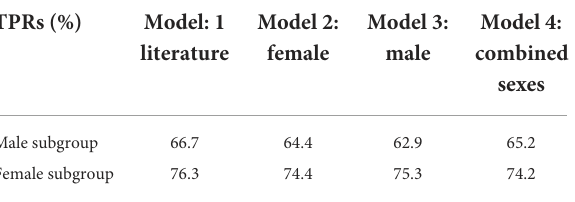
TABLE 4 Bayesian models were trained on one of the following sources of symptom prevalence, described in Methods: literature search; in house female data; in house male data; combined sexes in house